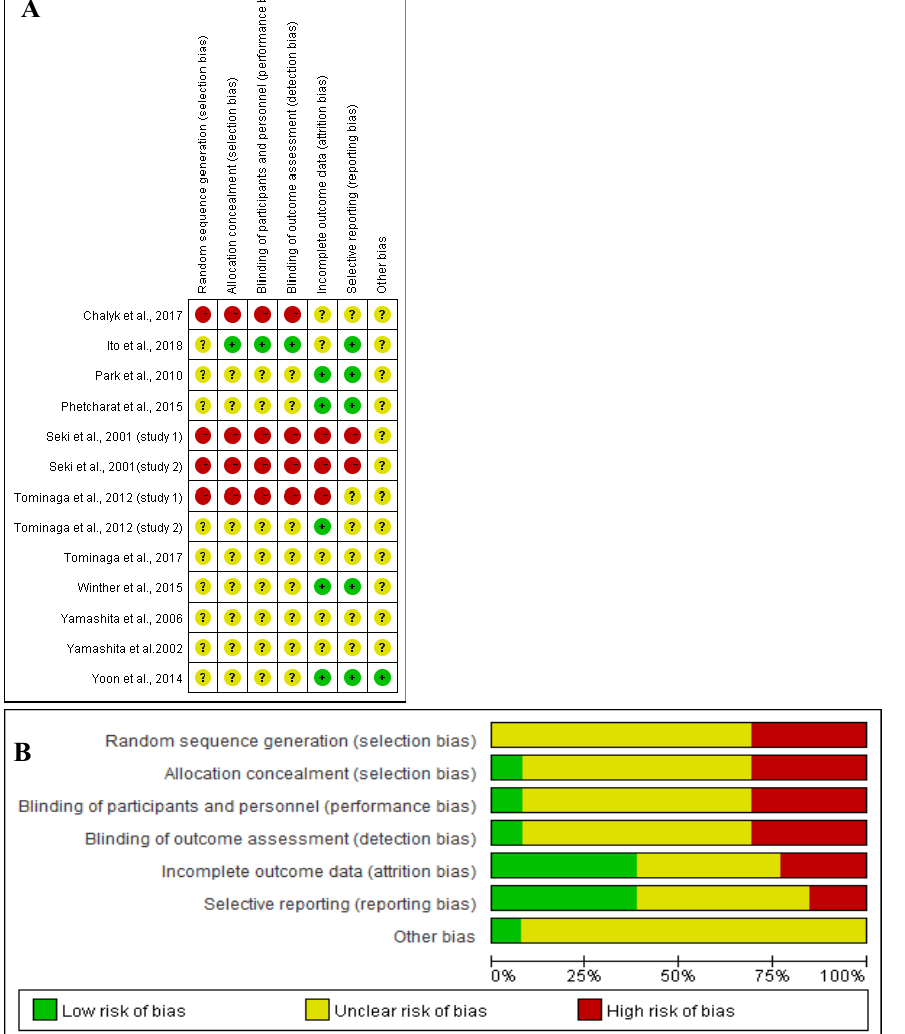
Figure 5. ( A ) Graph of RoB for each study according to the seven domains defined by Cochrane Collation’s tool. ( B ) Review of each RoB item presented as percentages across all included studies according to the judgments of the author.